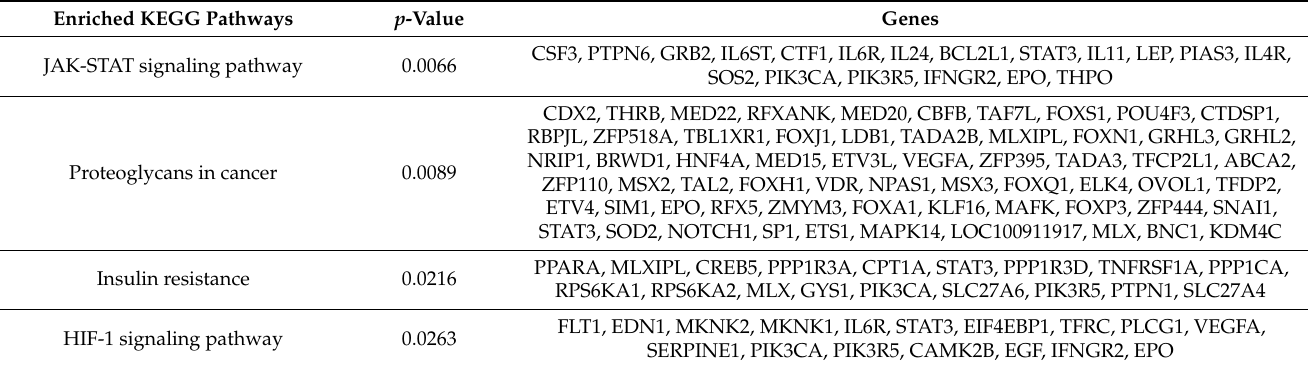
Table 1. Pathway enrichment analysis of the predicted target genes of miR-125a.